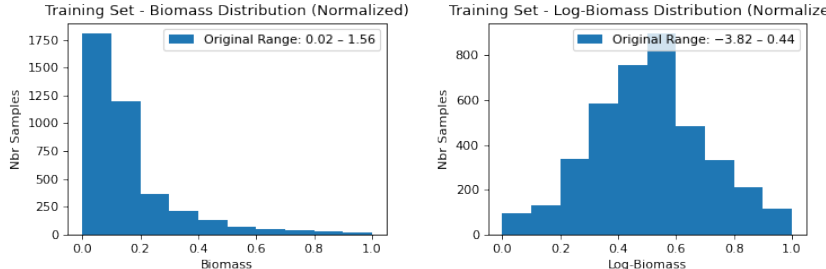
Figure 3. Effect of log-transform and normalization on biomass distribution for target data.